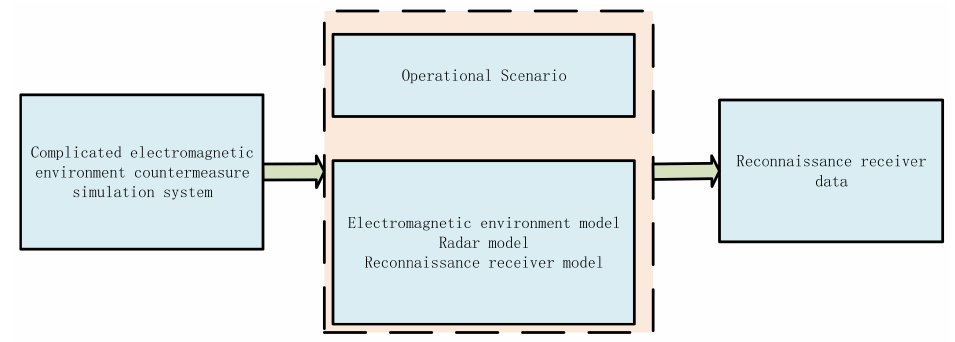
Figure 4. Method of generating experimental